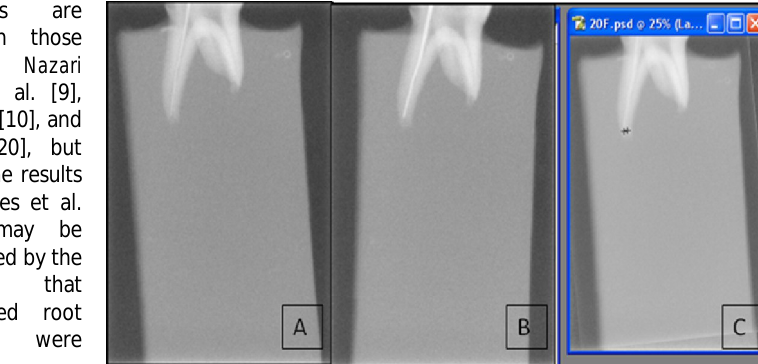
Figure 5: (A) Initial radiograph; (B) Final radiograph; (C) Overlay of digital images.